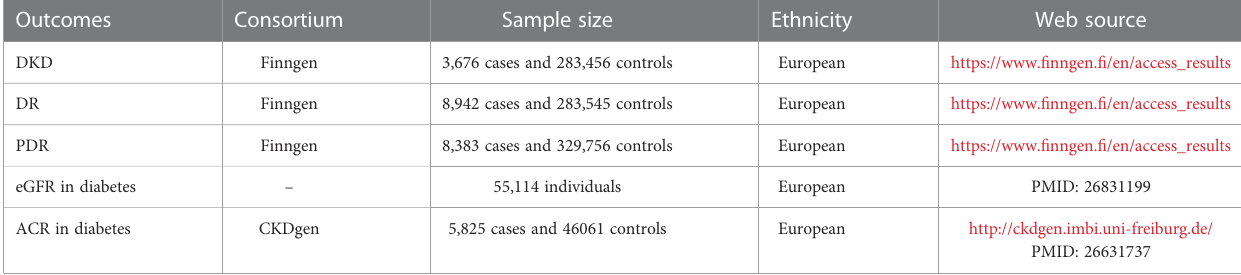
DKD, diabetic kidney disease; DR, diabetic retinopathy; PDR, proliferative diabetic retinopathy; eGFR, estimated glomerular fi ltration rate; ACR, urinary albumin-to-creatinine